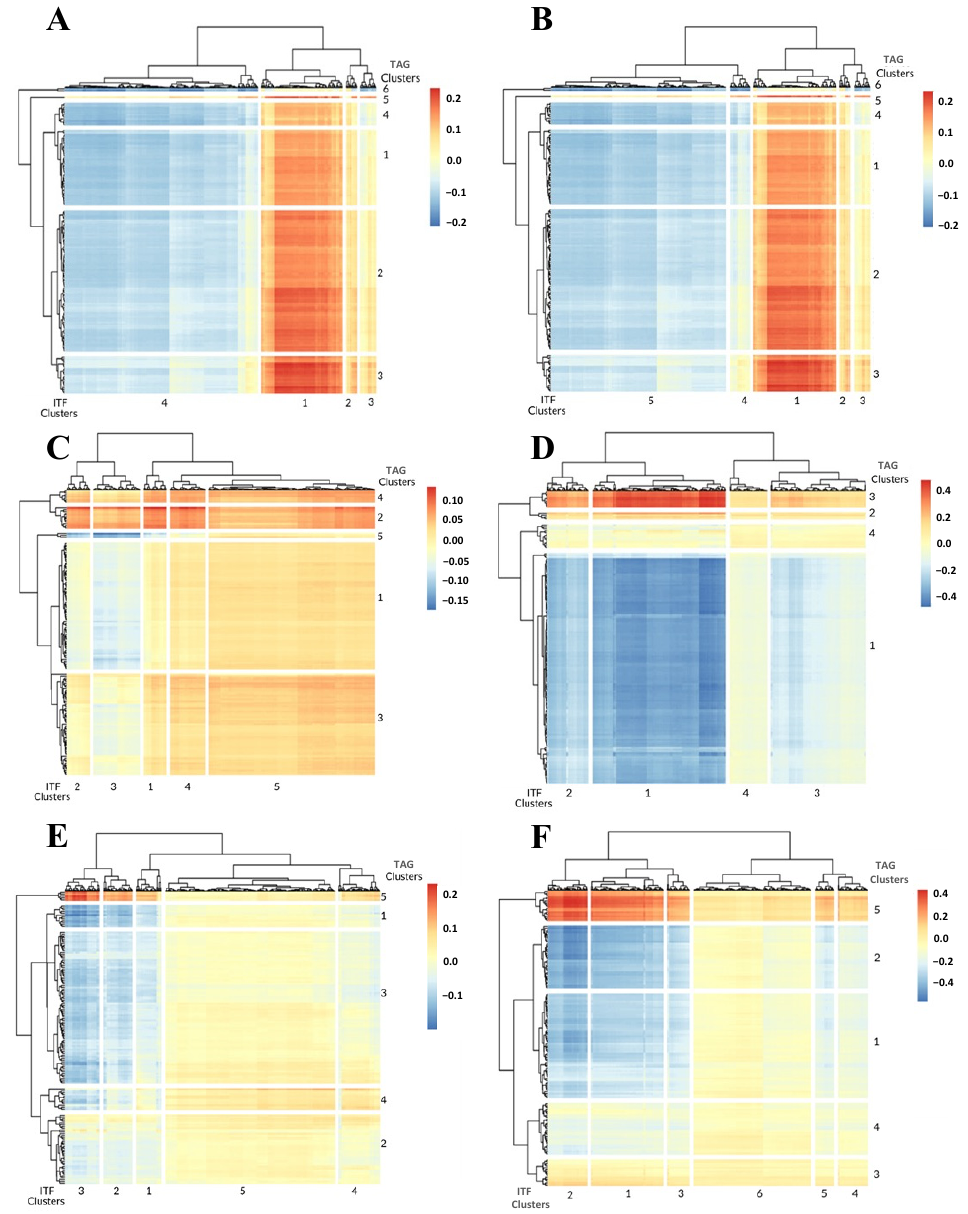
Figure 3. Heatmap of correlation matrix between 0-dimensional image features and gene expression values for Parent Visium Human Breast Cancer ( A ), Parent Human Breast Cancer ( B ), FFPE Human Breast Cancer ( C ), Human Prostate Cancer ( D ), Prostate Acinar CarcinoI ( E ), and Visium FFPE Human Normal Prostate ( F ).